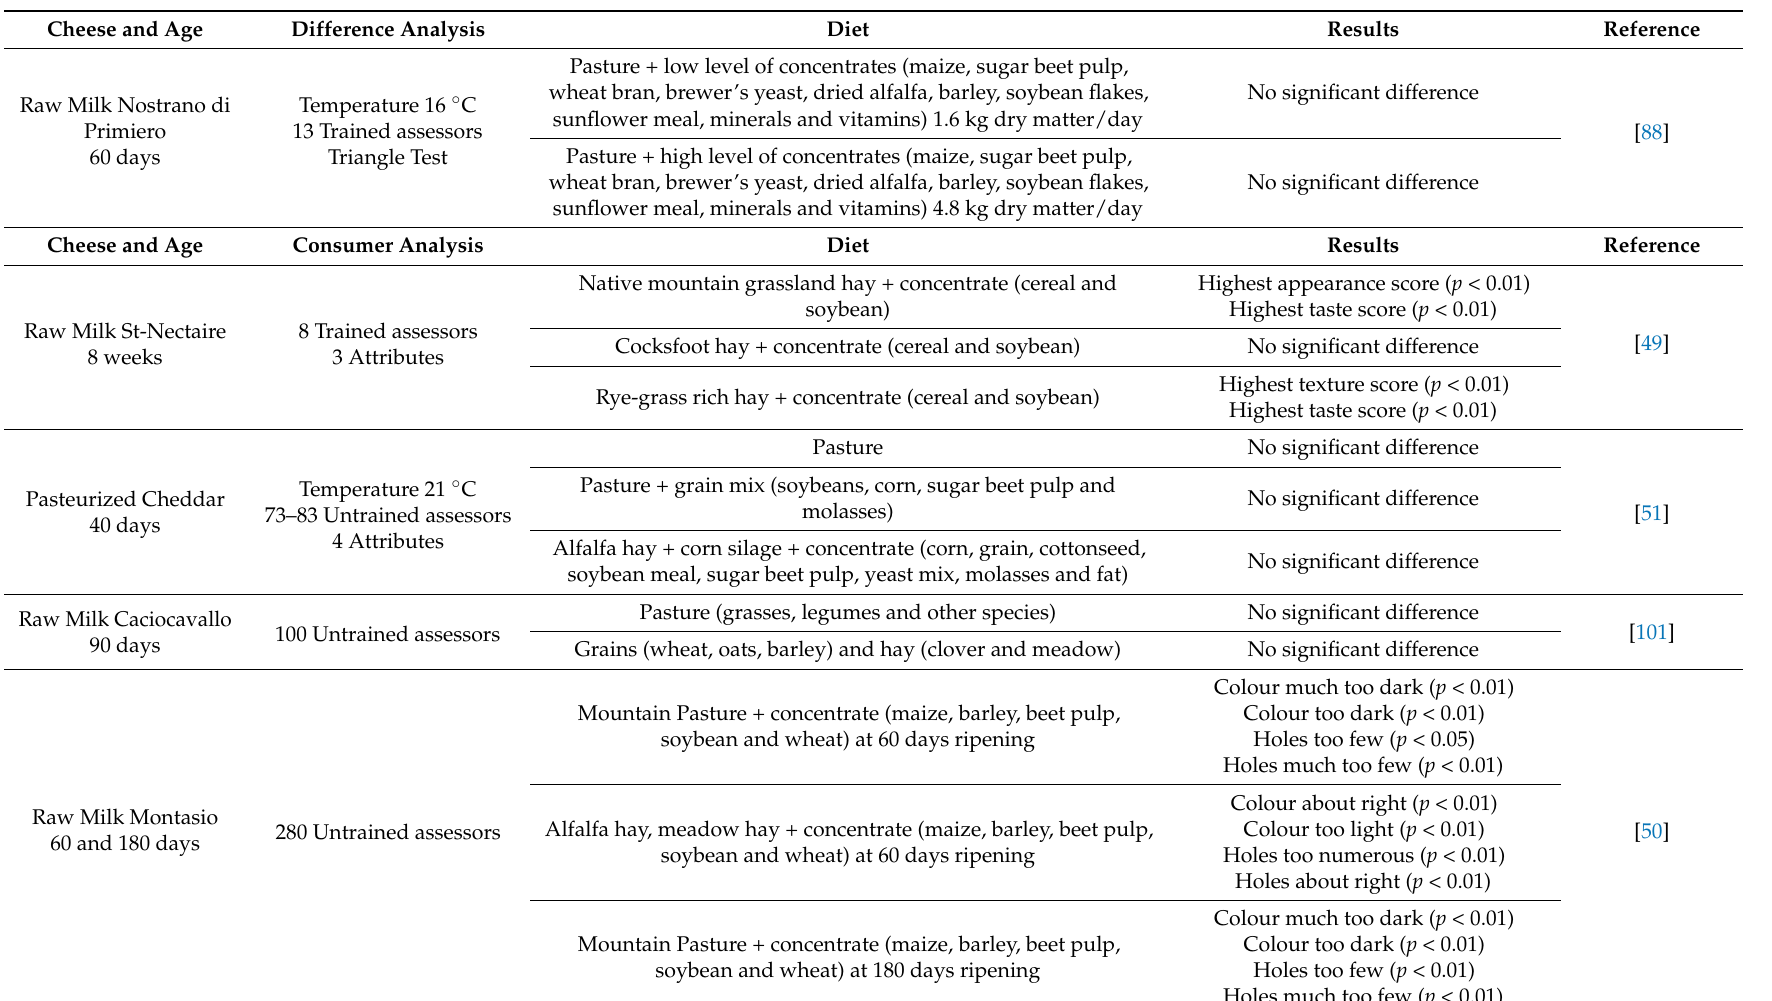
Table 5. Summary of difference and consumer sensory studies on bovine